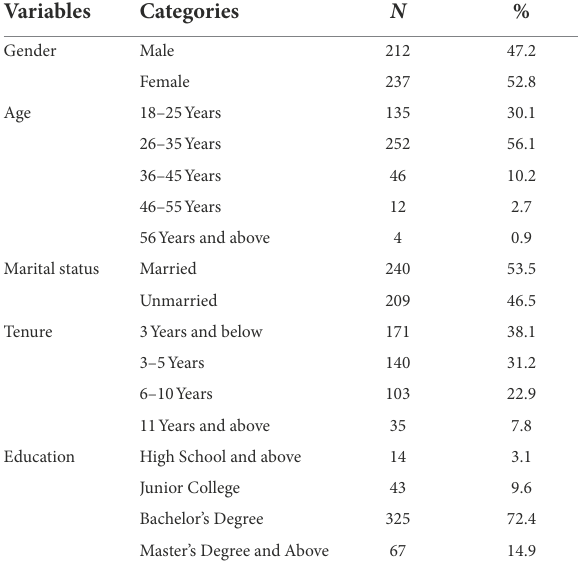
TABLE 1 Sample characteristics (n =